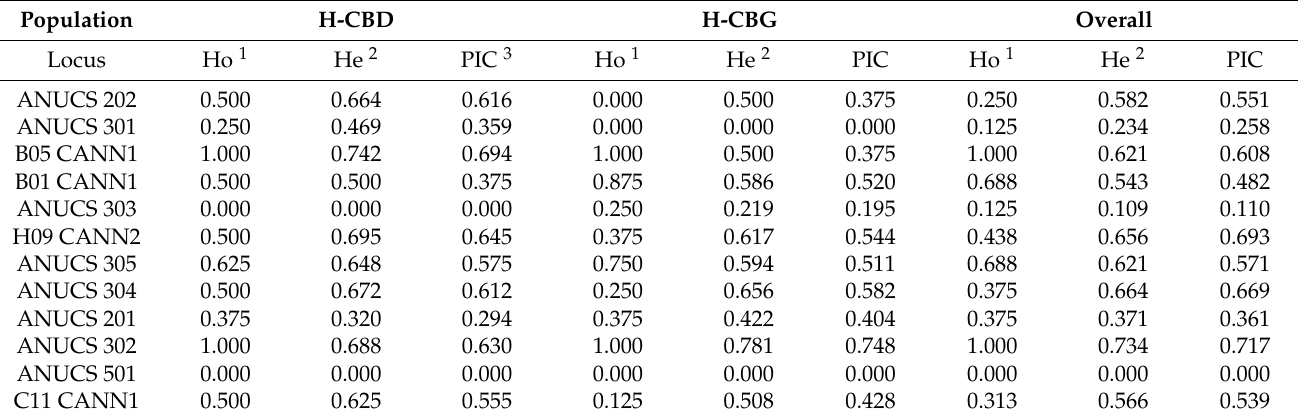
Table 3. Characteristics of studied STR locus and plant material of Cannabis sativa L. varieties.